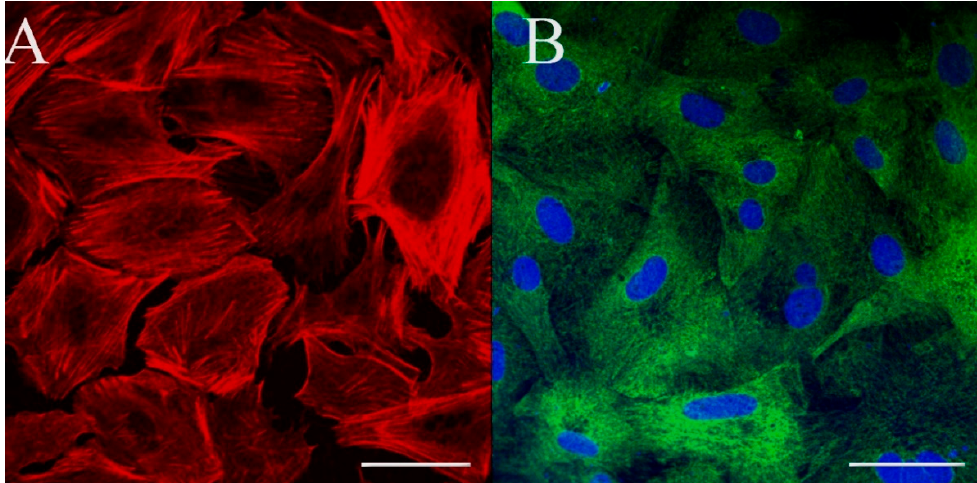
Figure 7. Cytoskeletal filament profile of the LG-1 cells. F-actin ( A ; phalloidin; red) and cytokeratin ( B ; green) were stained and visualized by confocal microscopy. Scale bar = 50 µm.